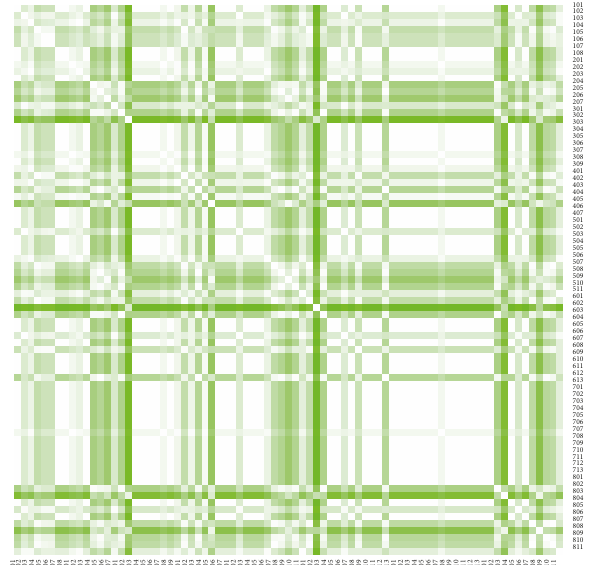
Figure 14: The distance matrix of the similarity of the districts for the male sex in 2005.